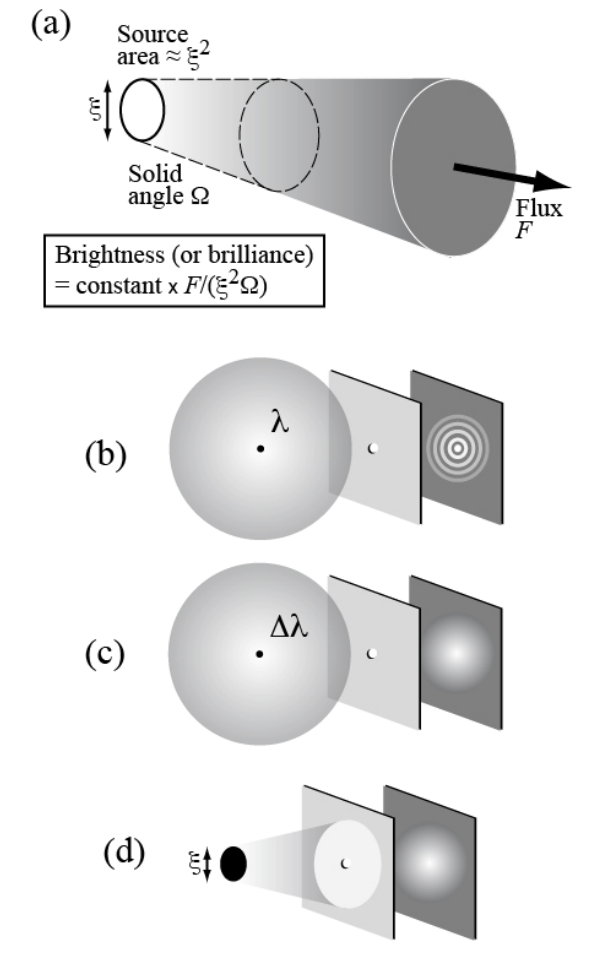
Figure 5. (a) Schematic definition of the essential source parameter “brightness” or “brilliance”. (b), (c) and (d) definition of time and spatial coherence by using diffraction by a